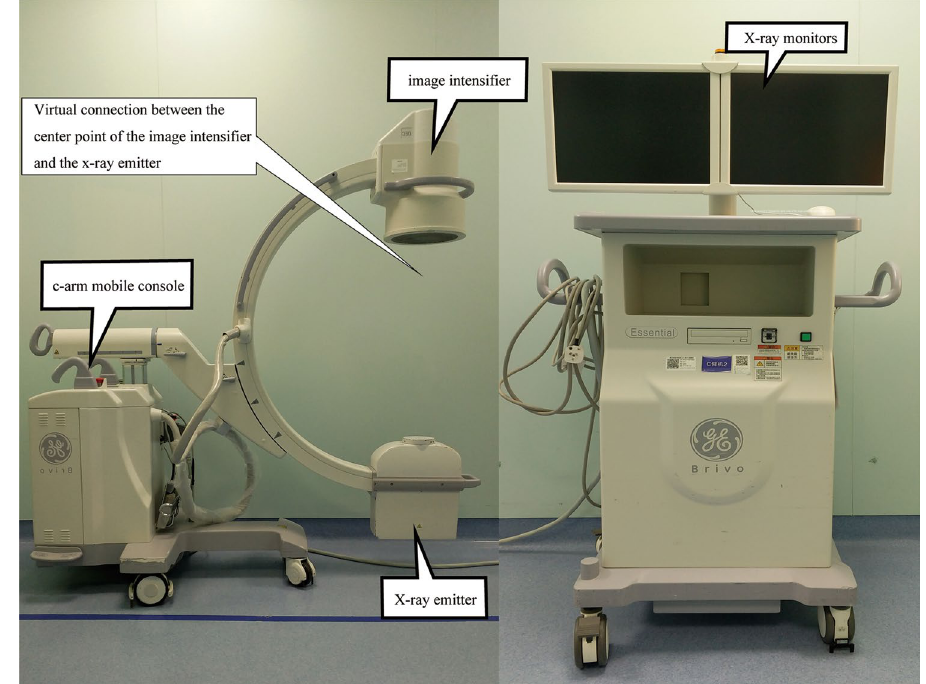
Figure 1. C-arm machine, model: Siemens